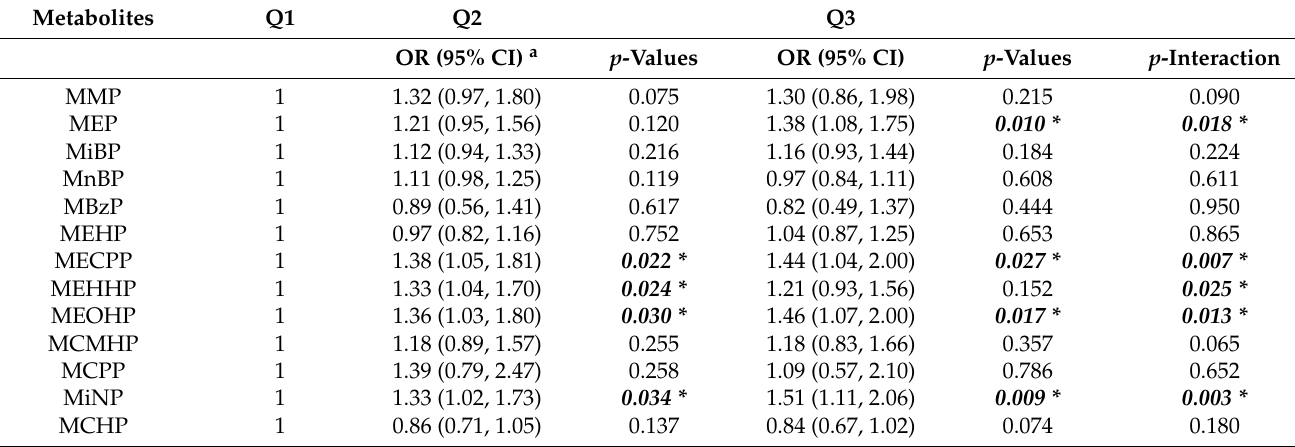
Table 5. ORs for the association between urinary phthalate metabolites and thyroid nodule according to blood lead levels in